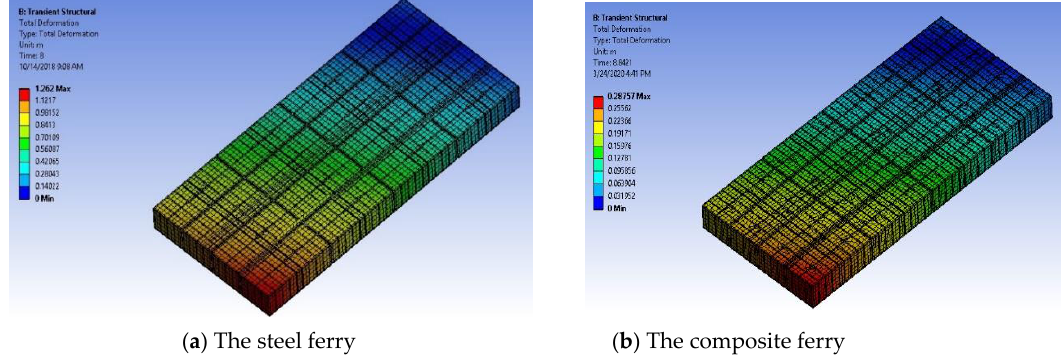
Figure 27. The total deformation in case 3.